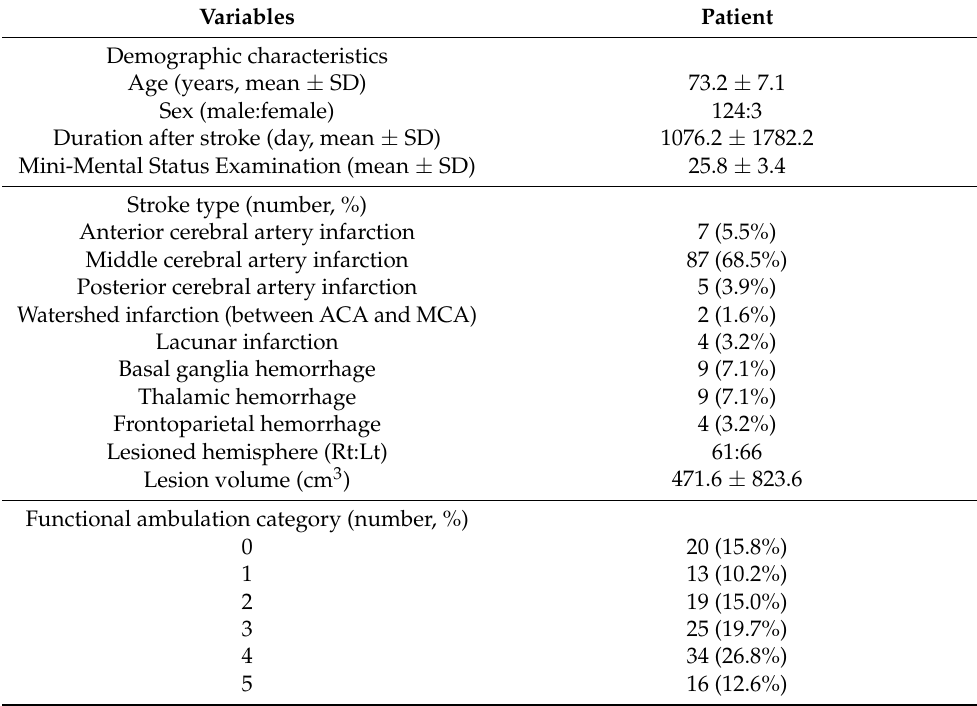
Table 1. General characteristics and functional ambulation category of included patients. Variables